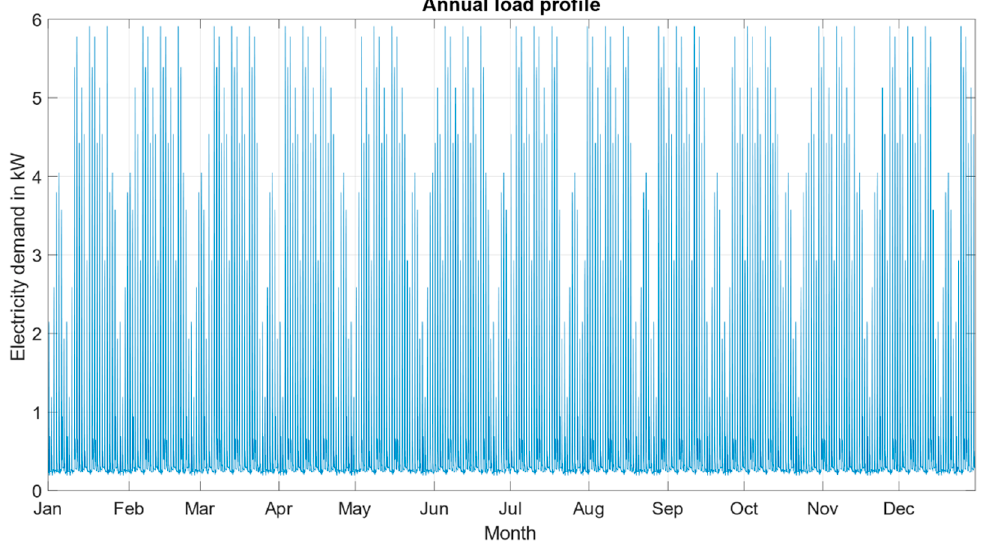
Figure 12. Annual hourly electricity demand profile from the measurement during moon phases.